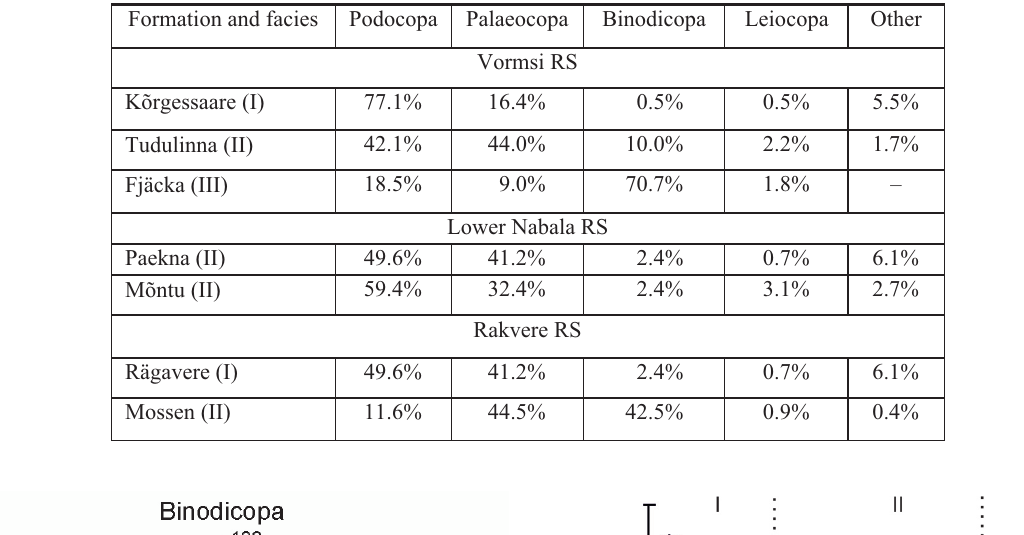
Table 2. Average relative abundance of principal ostracod groups in the studied formations;